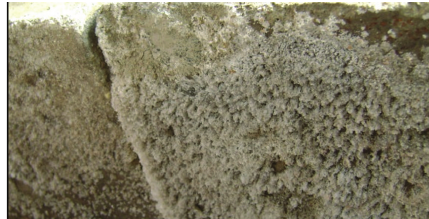
Figure 5: White deposits on geopolymer specimens exposed to magnesium sulphate solution.